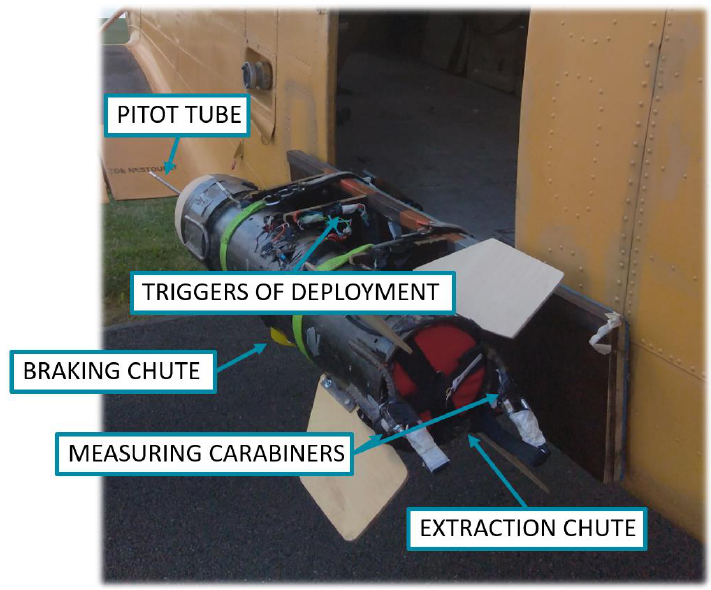
Figure 8. A scheme of a fully equipped laboratory mounted on the AN-2 before takeoff.